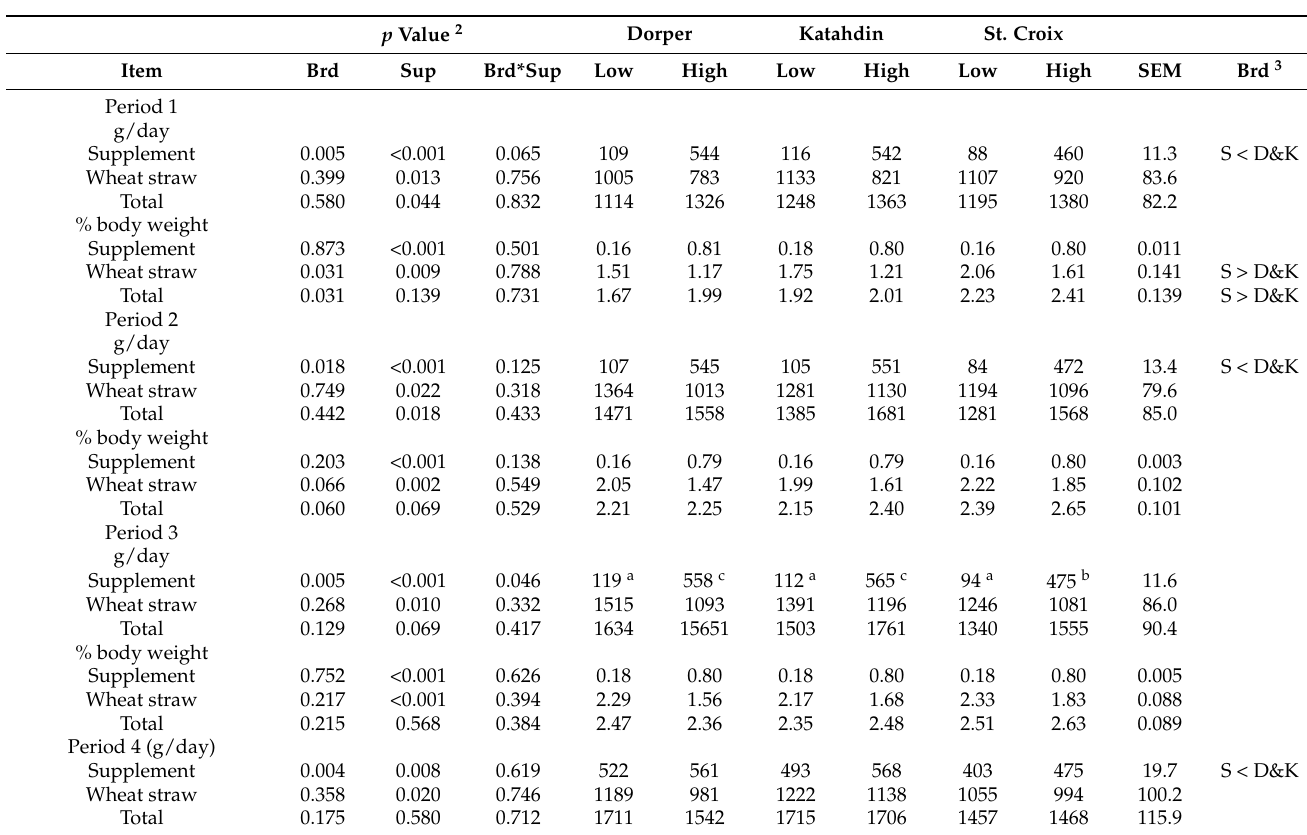
Table 2. Effects of breed and supplementation treatment on dry matter intake by hair sheep 1